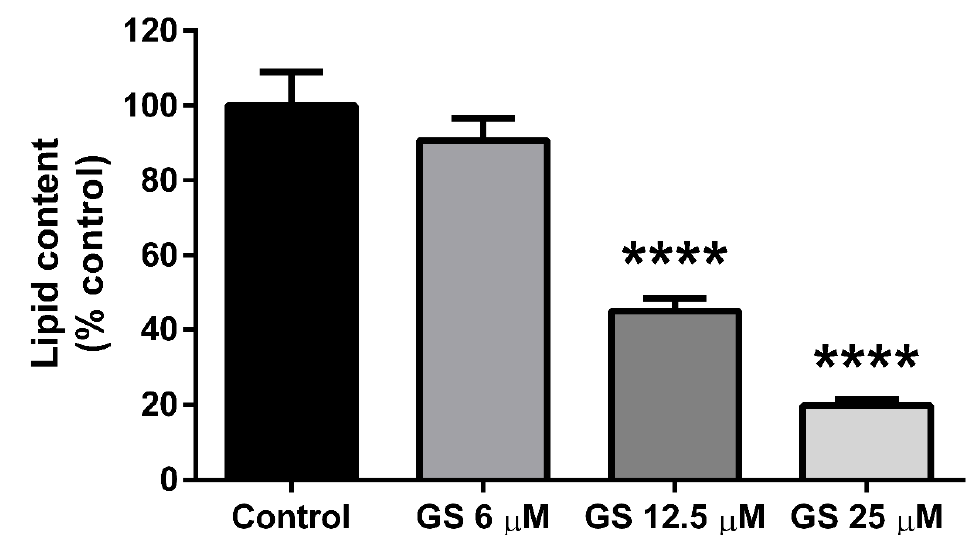
Figure 1. Guggulsterone (GS) reduced lipid accumulation in 3T3-L1 adipocytes. GS treatment during the differentiation period in 3T3-L1 adipocytes reduces adipogenesis in a dose dependent manner. Data presented as mean ± SEM from n = 3–6 replicates per group. **** p < 0.0001 vs. control.